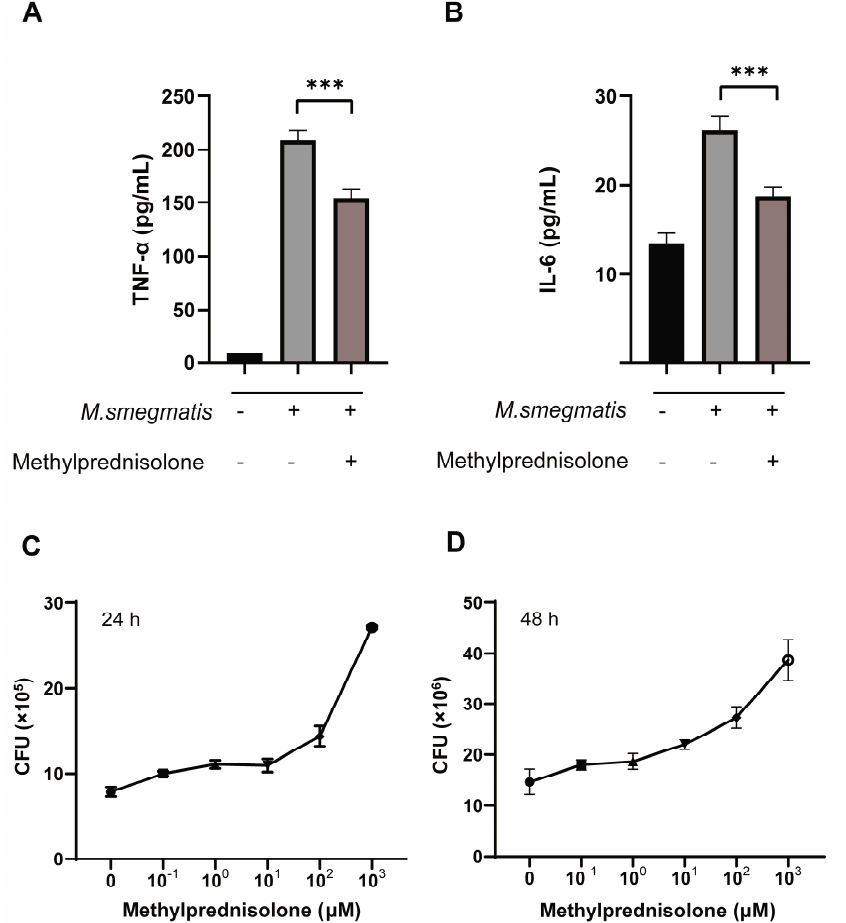
Figure 1. ( A , B ) Methylprednisolone (10 2 μ M) treated M. smegmatis infected RAW264.7 cells for 48 h;